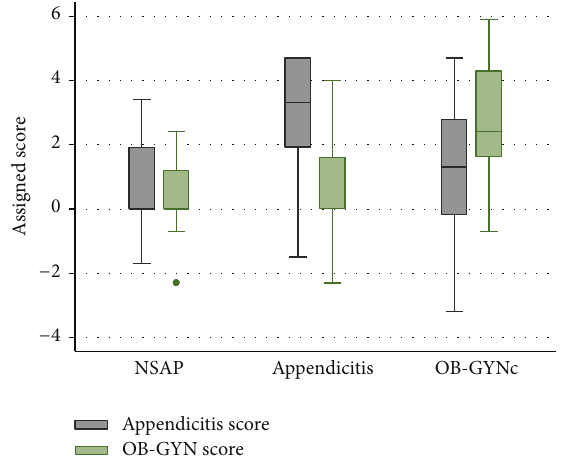
Figure 1: Distribution (box plot) of appendicitis score and OB- GYN score in nonspecific abdominal pain (NSAP), appendicitis, and common obstetrics and gynecological conditions (OB-GYNc).